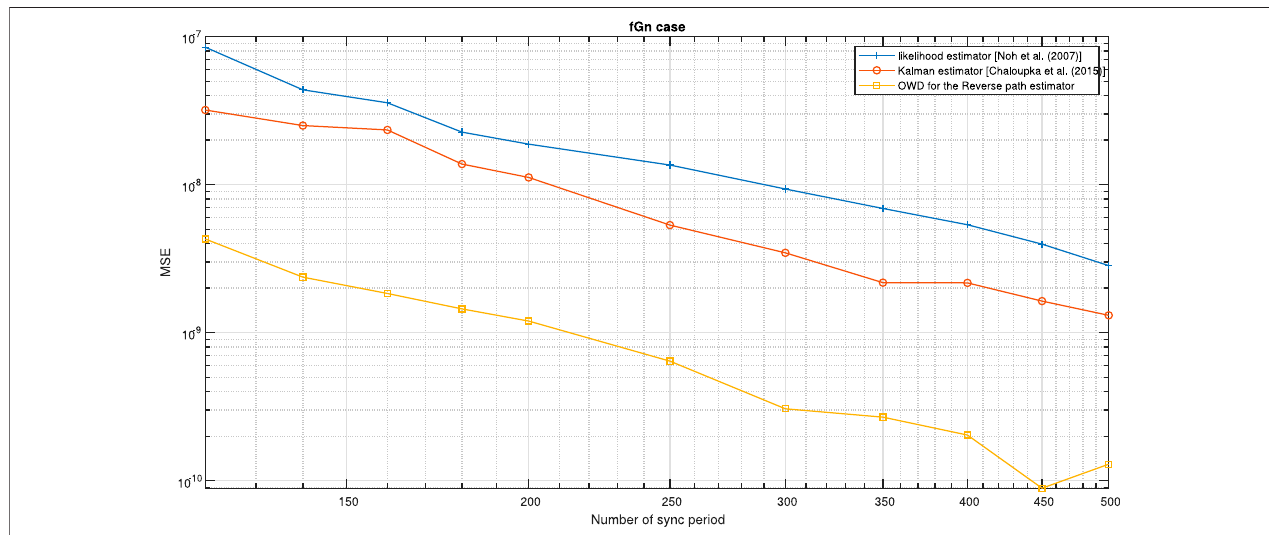
FIGURE12 | Performance (MSE) comparison between the OWDclock skew estimator forthe Reverse path ( Eq. 62 ),likelihood clock skew estimator proposed by Noh et al. [5] and Kalman clock skew estimator proposed by Chaloupka et al. [6]. The PDV is an fGn process. α = 50 ppm , Q = 5 ms , T syn (cid:2) 15 . 6 ms ( 64 packet